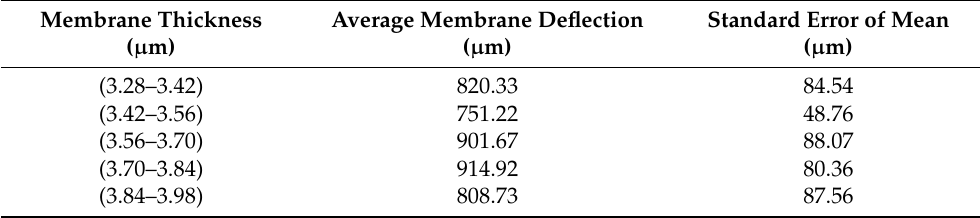
Table 4. Measured average deflection values of membranes with different thickness ranges.